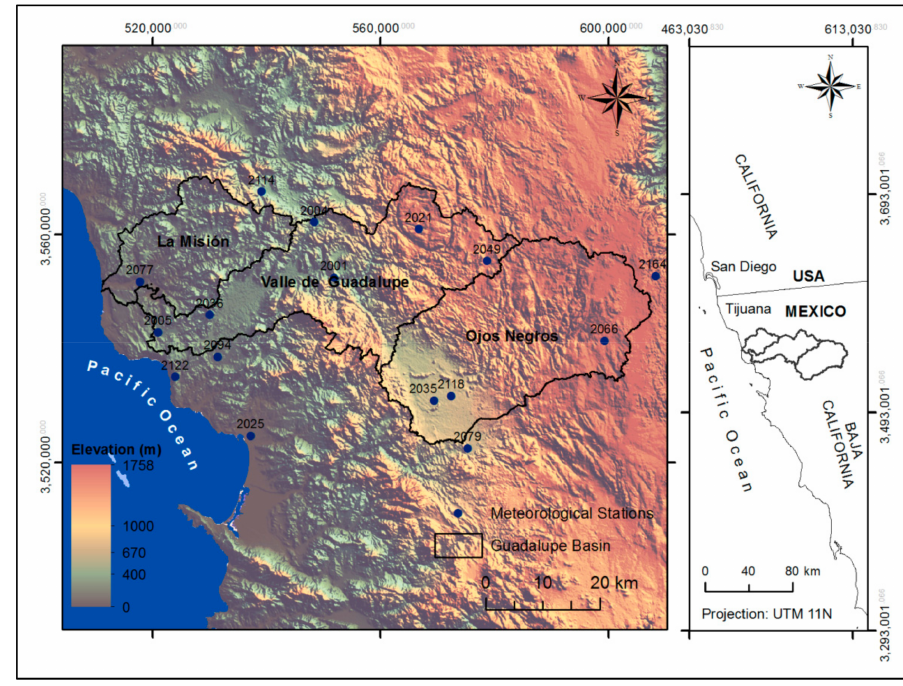
Figure 1. Study area